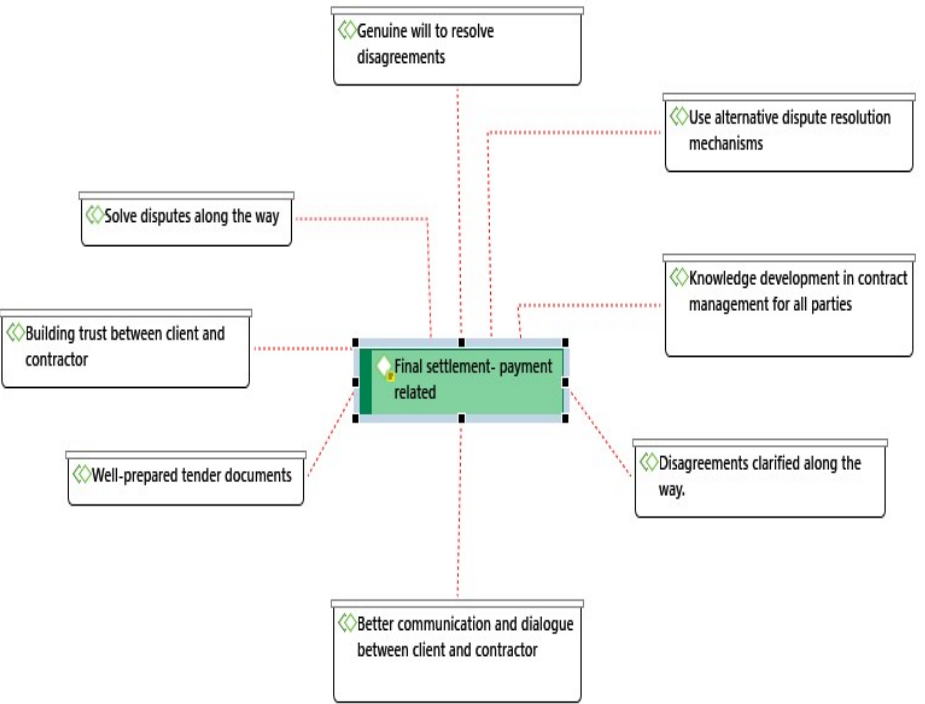
Figure 5. Thematic map 2.